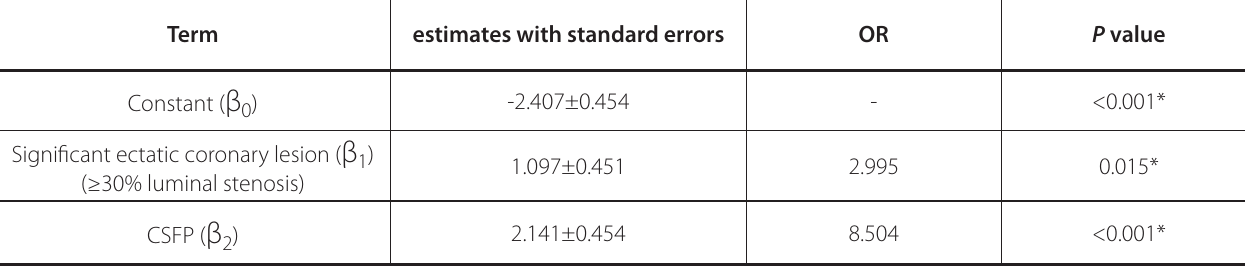
Table 6 . Relationship of ectatic coronary lesion and coronary slow flow with hospitalization.